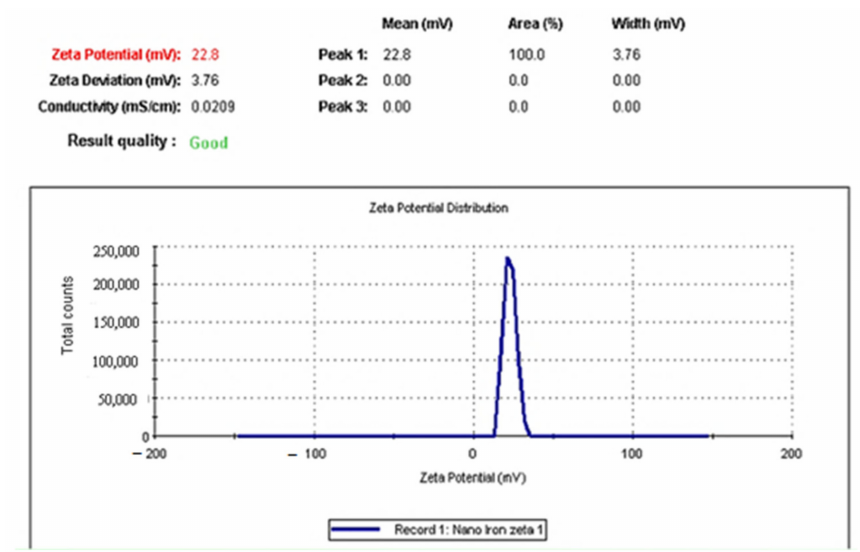
Figure 2. IONPs had a positive zeta potential value of +22.8 mV.